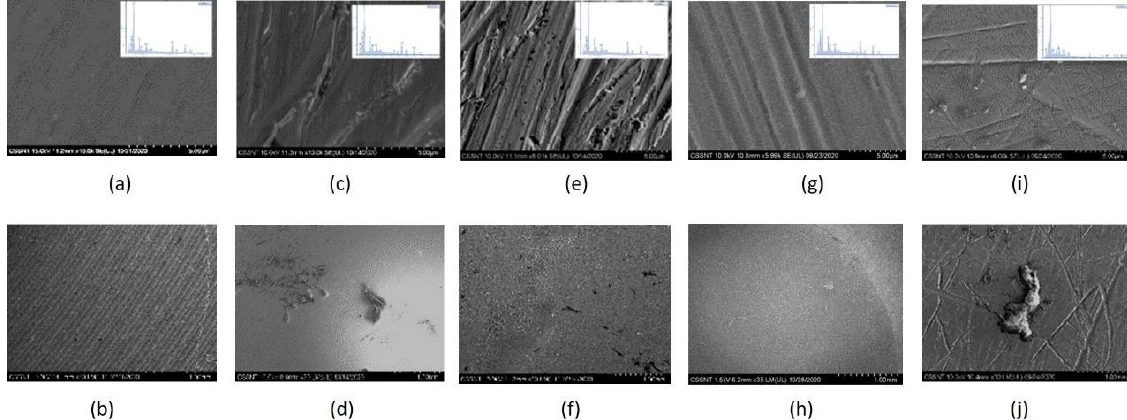
Figure 10. SEM micrographs and EDS analysis (inset) for CoCr alloy at two different magnification (35 x and 10 kx) ( a ) and ( b ) 290 K, ( c ) and ( d ) 300 K, ( e ) and ( f ) 310 K, ( g ) and ( h ) 320 K, ( i ) and ( j ) 330 K.